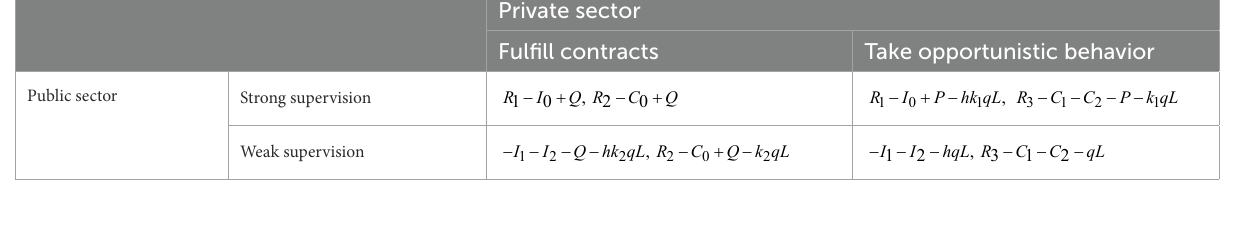
TABLE 3 Payoff matrix based on